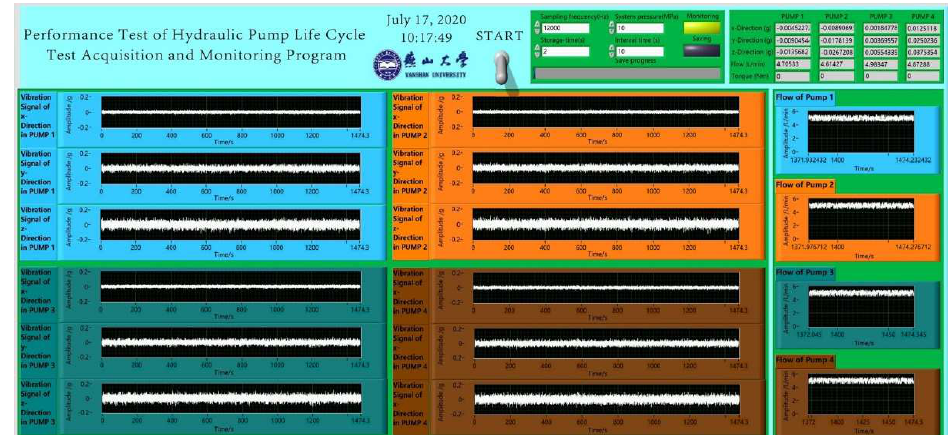
Figure 10. Data acquisition program front panel.